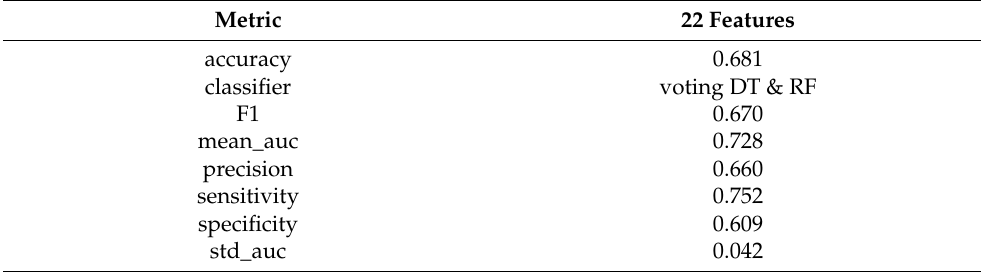
Table 5. Results from the best